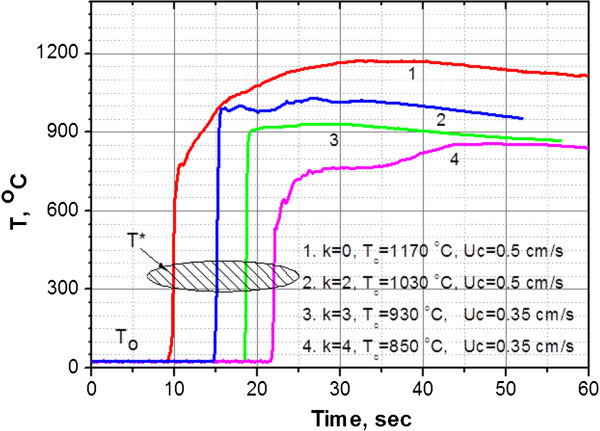
Temperature-time profiles in K2TaF7 + (5 + k)NaN3 + kNH4F system.